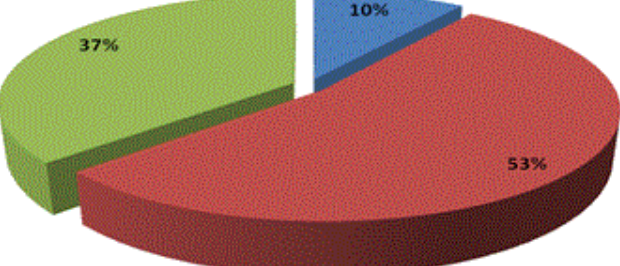
Figure 6: Number of years the SMEs